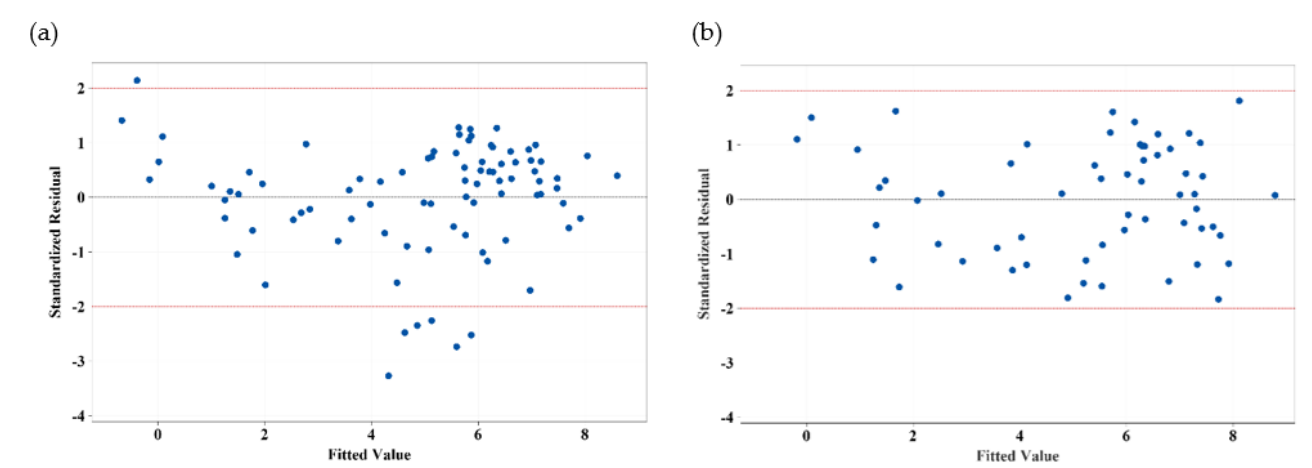
Figure 7. Standardized absolute residuals: ( a ) before; ( b ) after the jack-knife technique. Table 6. Summary of the model statistics for the constant term and different predictor variables